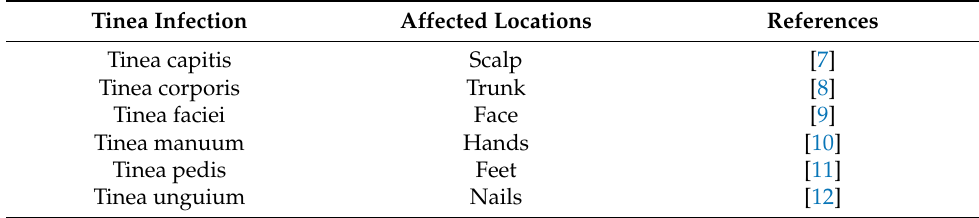
Table 1. The occurrence of Tinea infection in various body